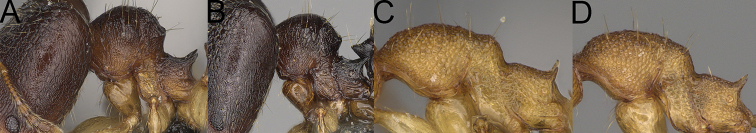
Profile. Pheidole
mavesatra sp. nov., major worker (A), minor worker (C). Pheidole
goavana sp. nov., major worker (B), minor worker (D).